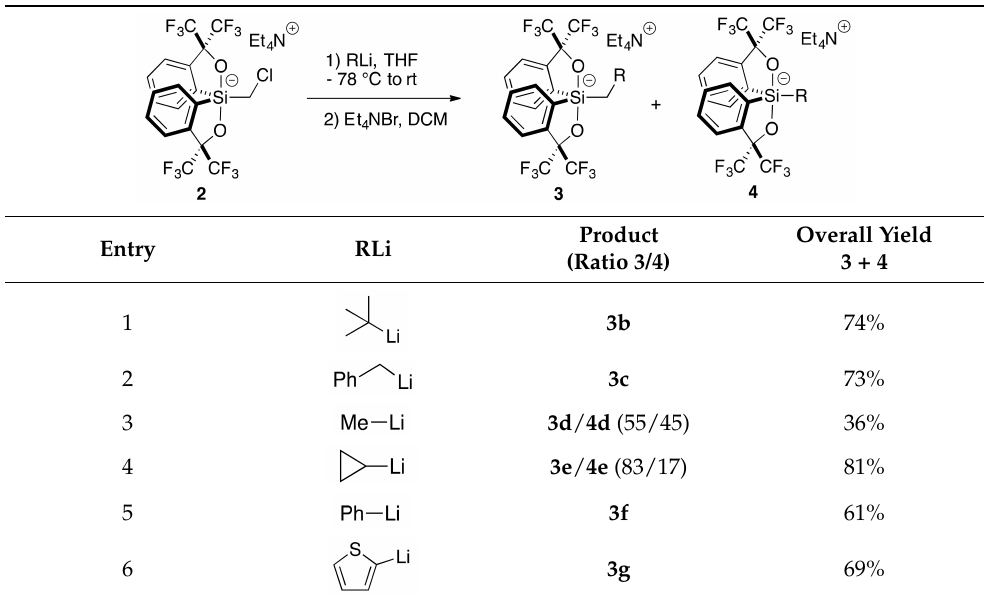
Table 1. Additions of various organolithiums to chloromethylsilicate 2